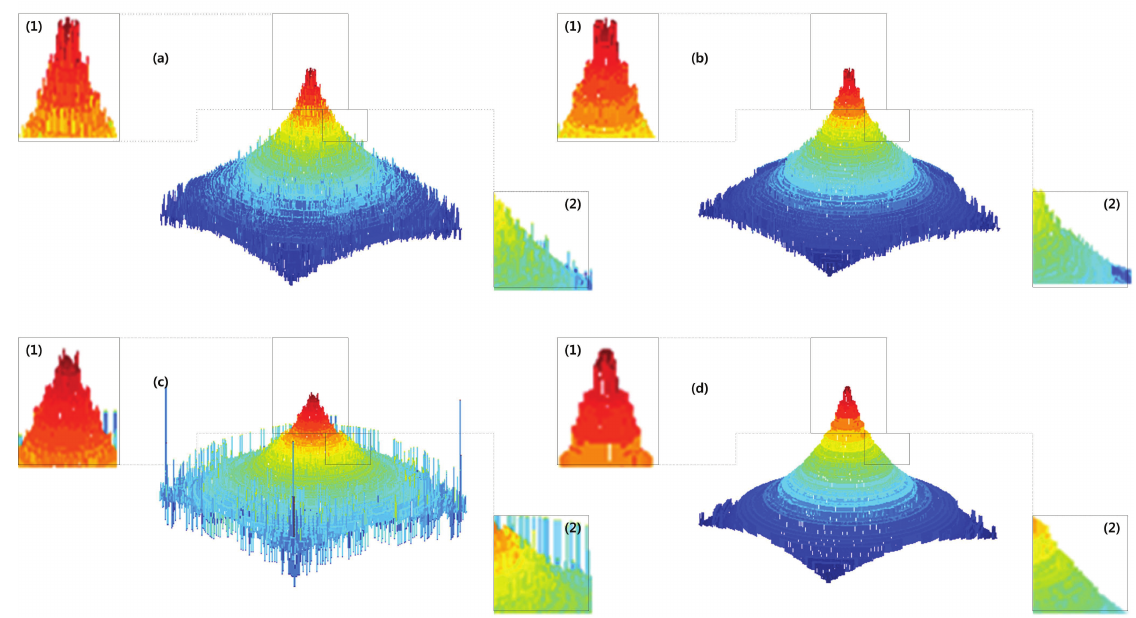
Figure 9. Depth maps for simulated cone: ( a ) ML; ( b ) GLV; ( c ) TEN; ( d ) the proposed method and their (1) tip; (2) side.